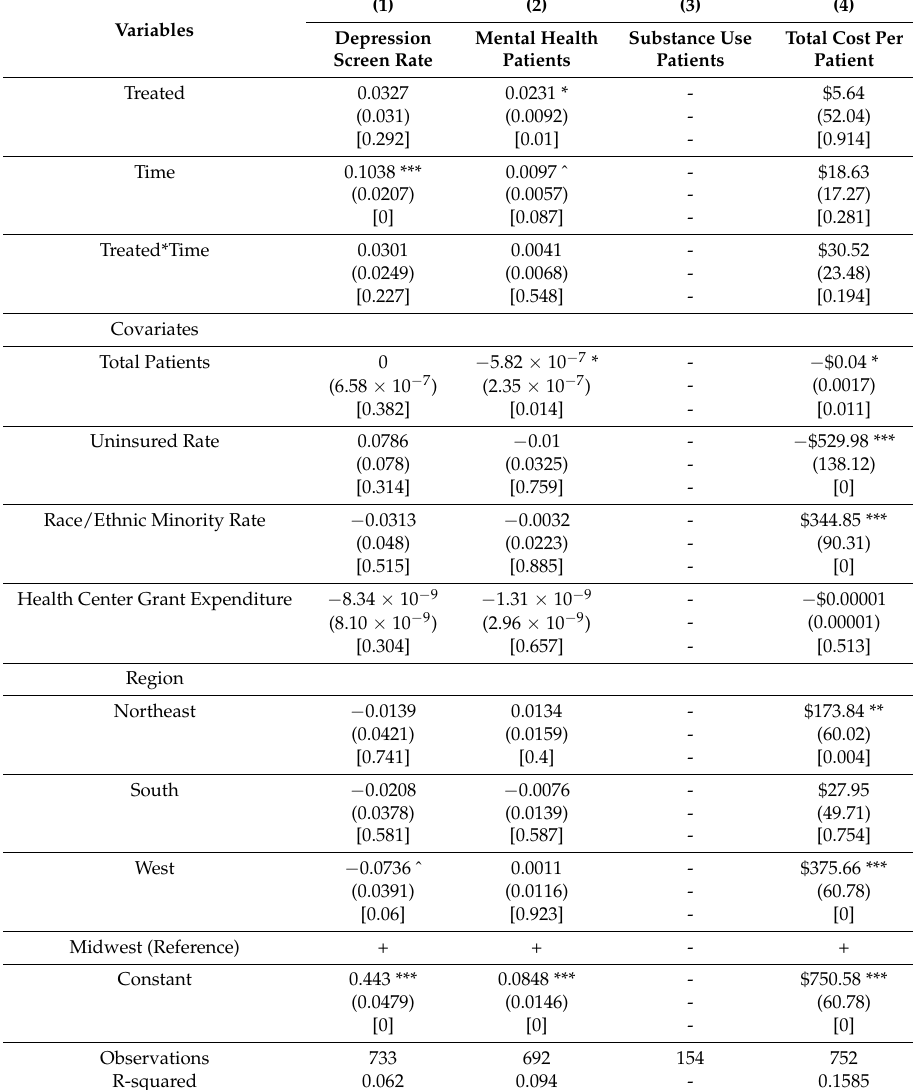
Table 4. Multivariate Regression Analysis: BHI Grantees vs. Propensity Score-Matched FQHC Comparison